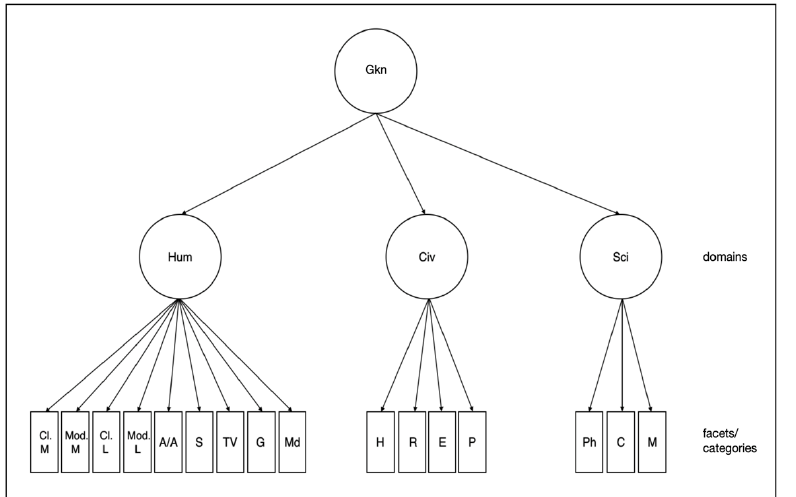
Figure 1. Hierarchical Structure of the Domain-specific Knowledge Model. Gkn = Domain-specific Knowledge, Hum = Humanities, Civ = Civics, Sci = Science, Cl. M = Classical Music, Mod. M = Modern Music, Cl. L = Classical Literature, Mod. L = Modern Literature, A/A = Art/Architecture, S = Sports, TV = Television, G = Geography, Md = Medicine, H = History, R = Religion, E = Economics, P = Politics, Ph = Physics, C = Chemistry, M = Mathematics.